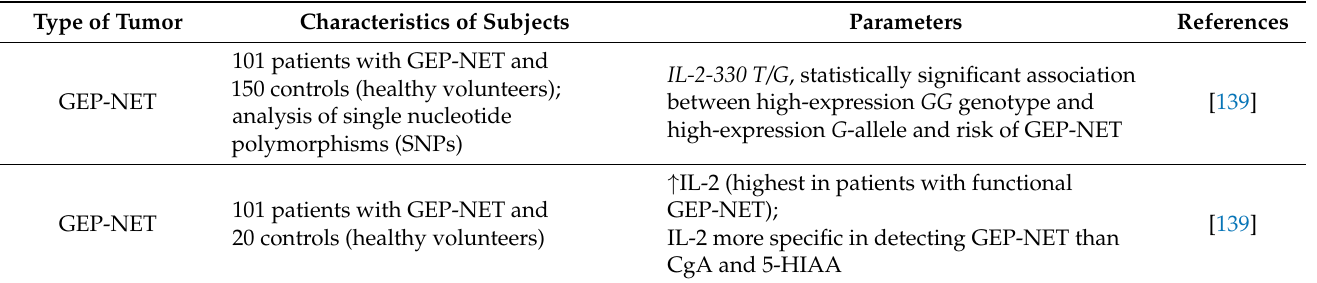
Table 1. Research on changes in selected parameters of inflammation in gastroenteropancreatic neuroendocrine tumors